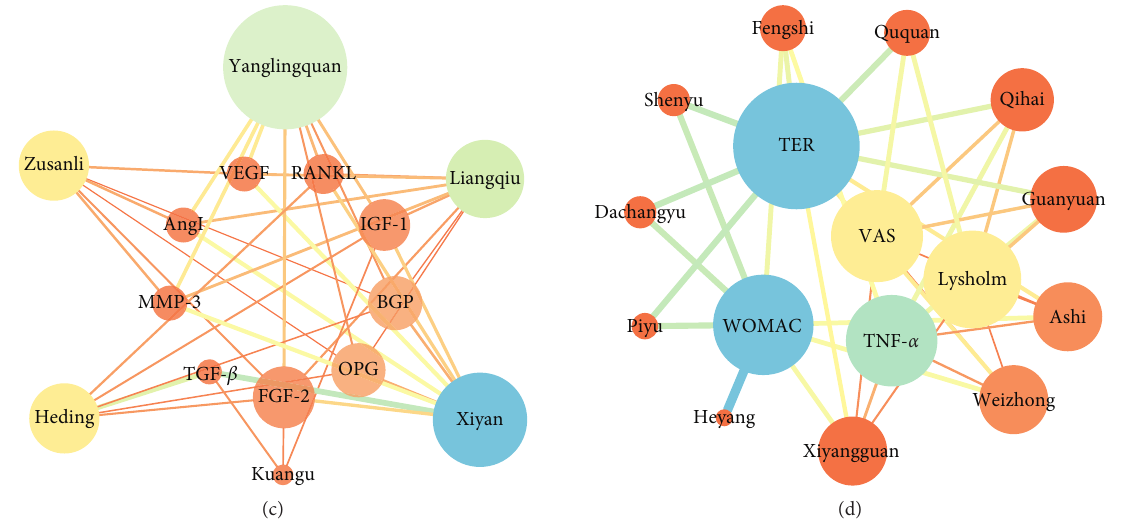
Figure 7: Corresponding relationship between the acupoint and index network. The larger nodes are represented by the main correspondence.